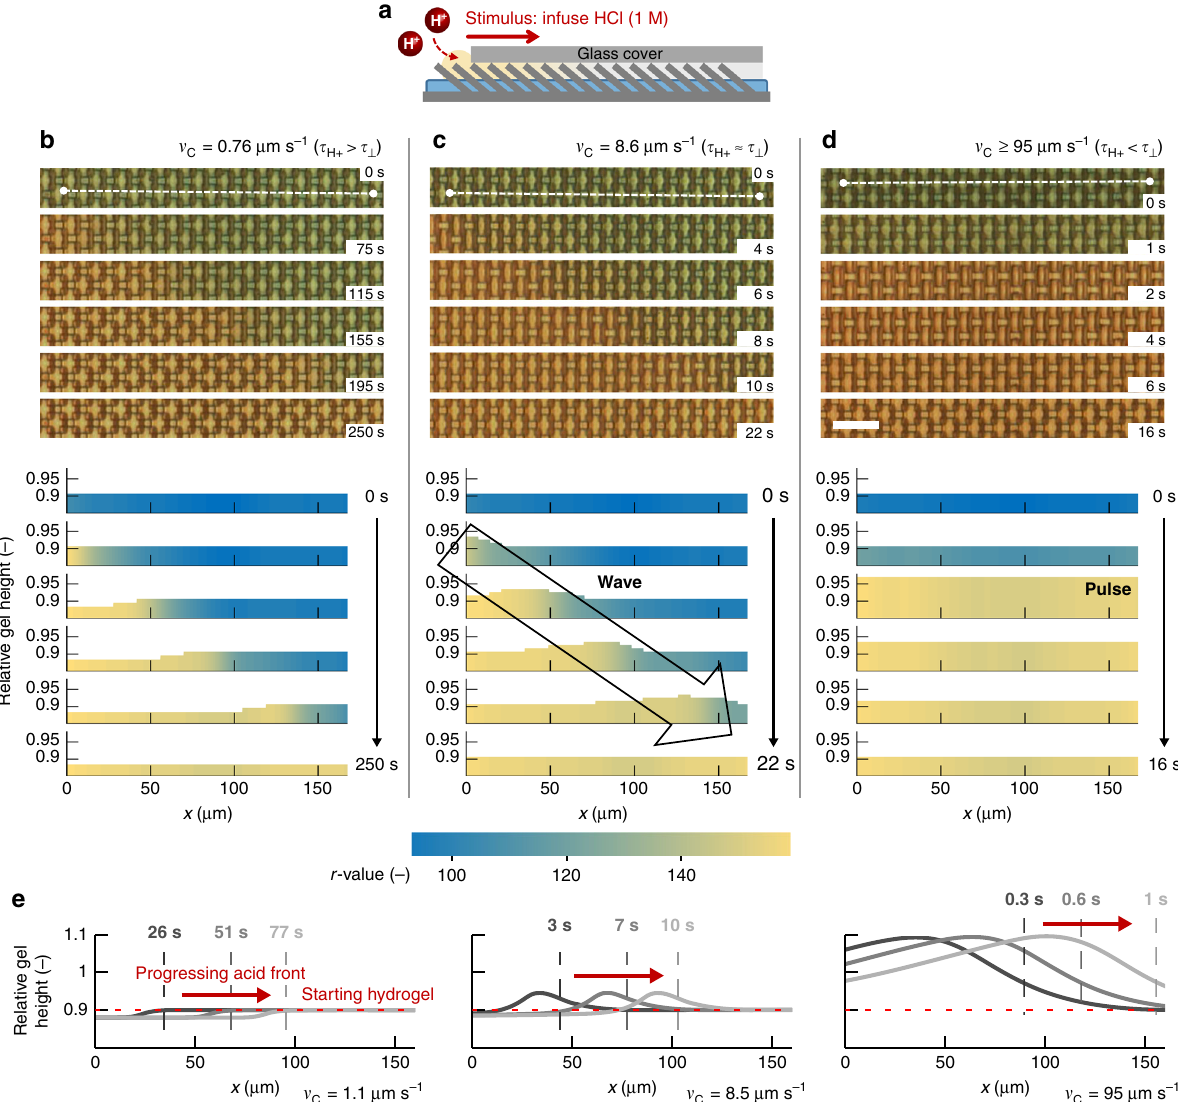
Fig. 4 Traveling swelling waves that are sensitive to the acid progression rate. a Schematic of the experimental design: HCl (1 M) is added from the left side of a Cu 2 + -contracted substrate covered with a thin water fi lm and a glass cover (see Methods). b – d (Top) Micrographs showing the progression of the acid stimulus at various rates, indicated by a blue-to-colorless transition. (Bottom) The height of the diagrams represents the evolution of the relative hydrogel height in time and space derived from the microplate tilt angle as described in Methods (Supplementary Fig. 1), along the white dashed line for the six micrographs from top to bottom; and the color of the diagrams represents the Cu 2 + release as characterized by the blue-to-colorless transition: b No swelling pulse is observed for the acid stimulus that travels from left to right over 190 μ m in 250 s ( v C = 0.76 μ m s − 1 ); c , d Faster progression of the acid within 22 s ( c v C = 8.6 µ m s − 1 ) and within 2 s ( d v C ≥ 95 µ m s − 1 ) generates swelling/contraction waves that travel at the acid front. Scale bar: 25 µ m. e The results of our continuum theory show that traveling swelling/contraction waves are only obtained at v C ≥ 8.5 µ m s − 1 for this set of experimental parameters, in excellent agreement with the experimental data. The red dashed lines indicate the starting height of the Cu 2 + -storing hydrogel; the vertical lines indicate the position of the progressing HCl front at three different times; the curves show the corresponding relative hydrogel height along the horizontal position x . The grayscale corresponds to three different times given in the legend of each